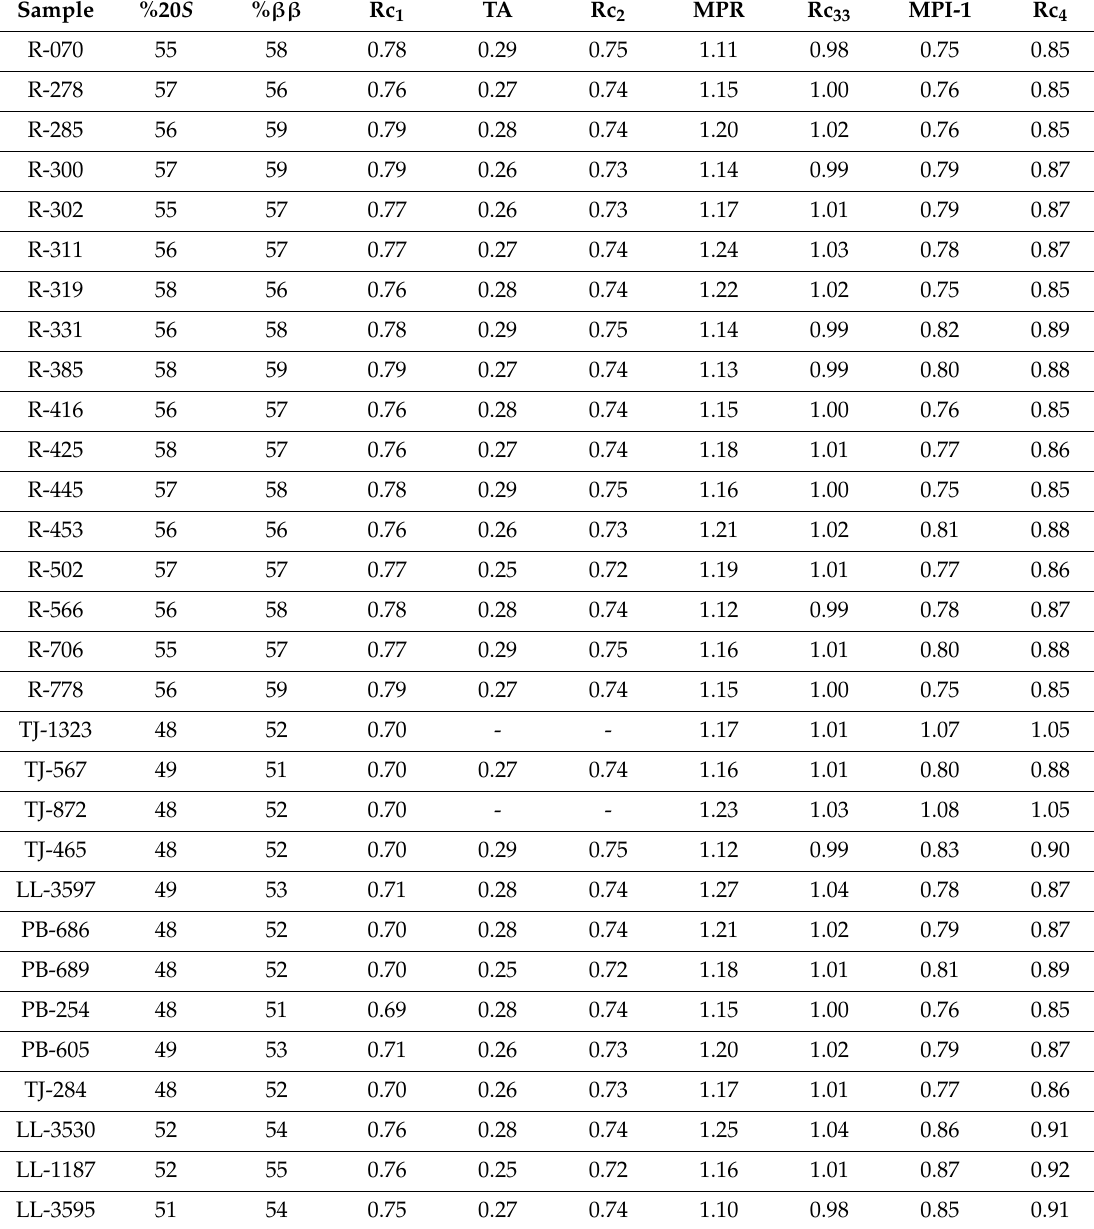
Table 4. Maturity-related molecular ratios of aromatic and saturated fractions in oils analyzed.